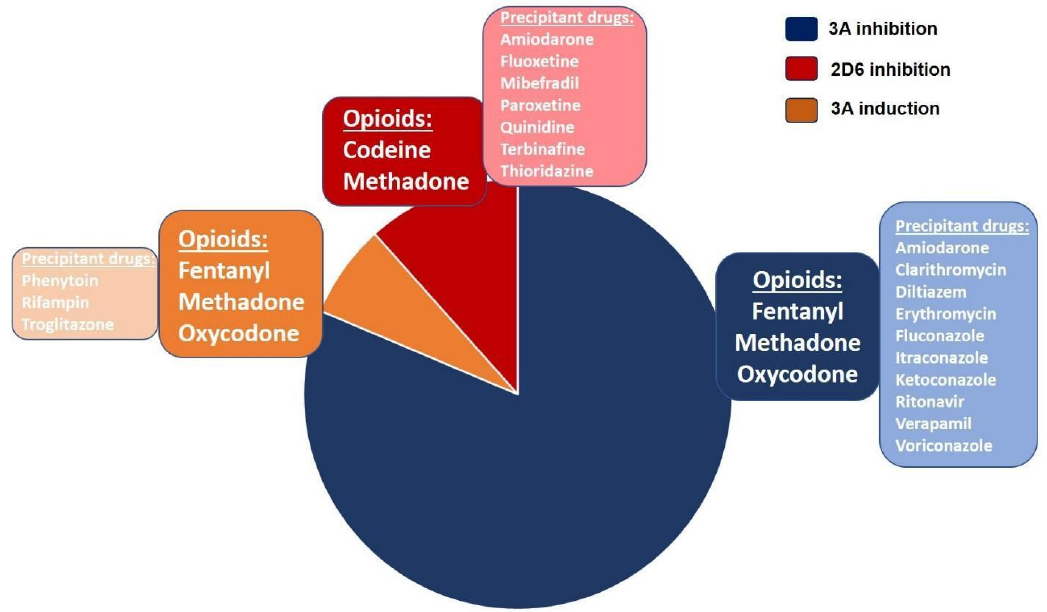
Figure 2. Most common CYP450-related pharmacokinetic drug–drug interactions between opioids and precipitant drugs (modified with permission from Pergolizzi et al. [125]).